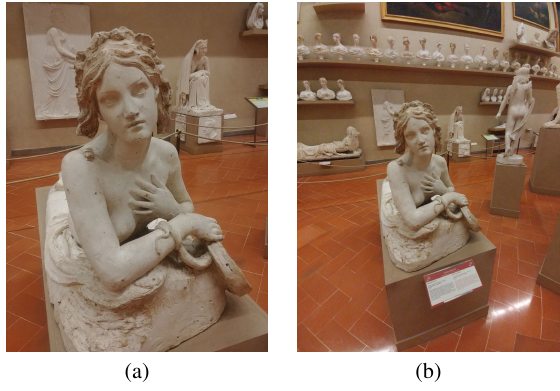
Figure 4. Couple of stereo images of a bacchante, Dirce, (Lorenzo Bartolini, Galleria dell’Accademia di Firenze) acquired with a smartphone LG G6.